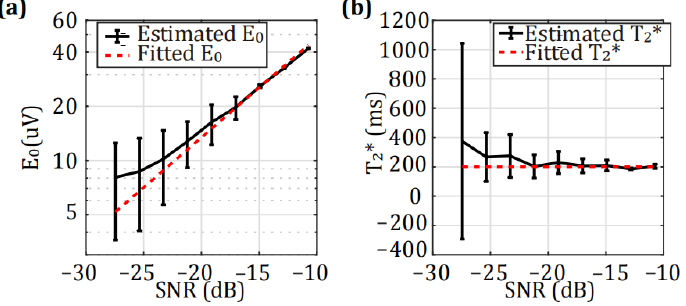
Figure 4. Fitting error maps of E 0 and T ∗ ( a ) E 0 , ( b ) T ∗ 2